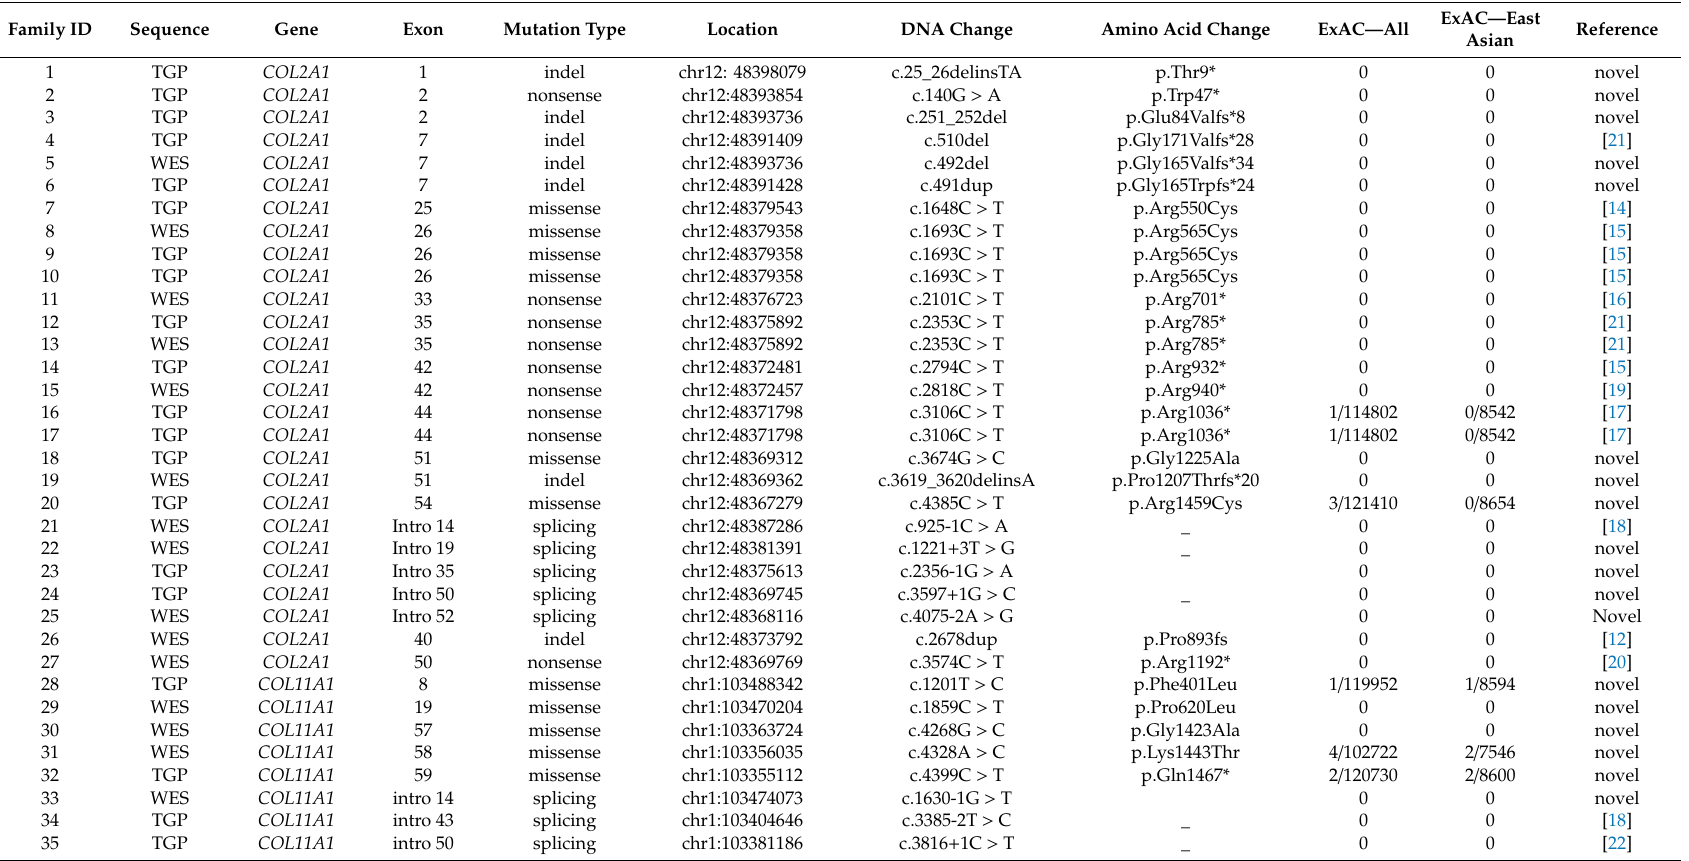
Table 2. Mutations detected in this